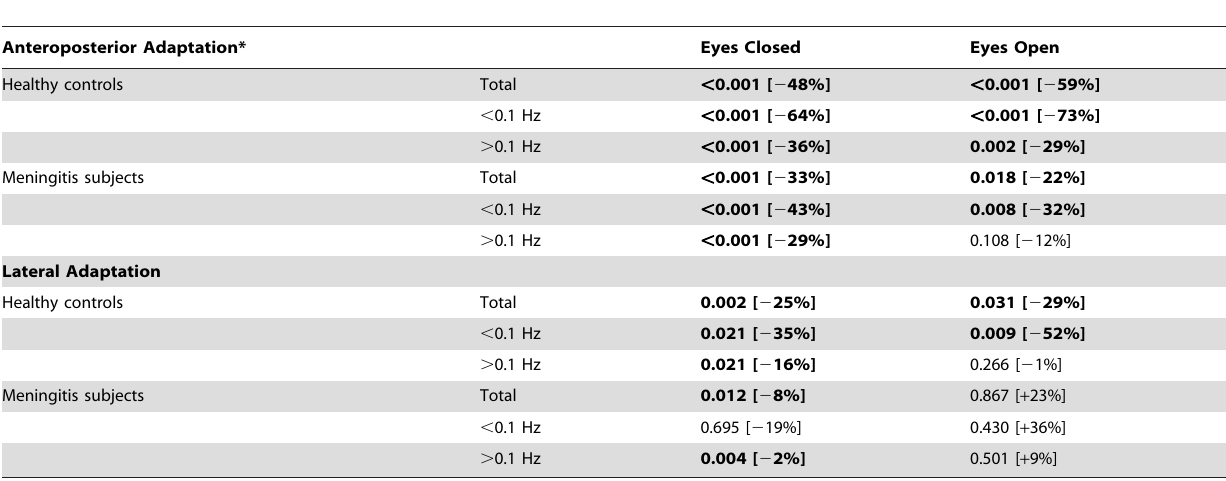
Table 4. Adaptive changes achieved by subjects treated in childhood for meningitis and by healthy controls, from period 1 to period 4 in the stimulation